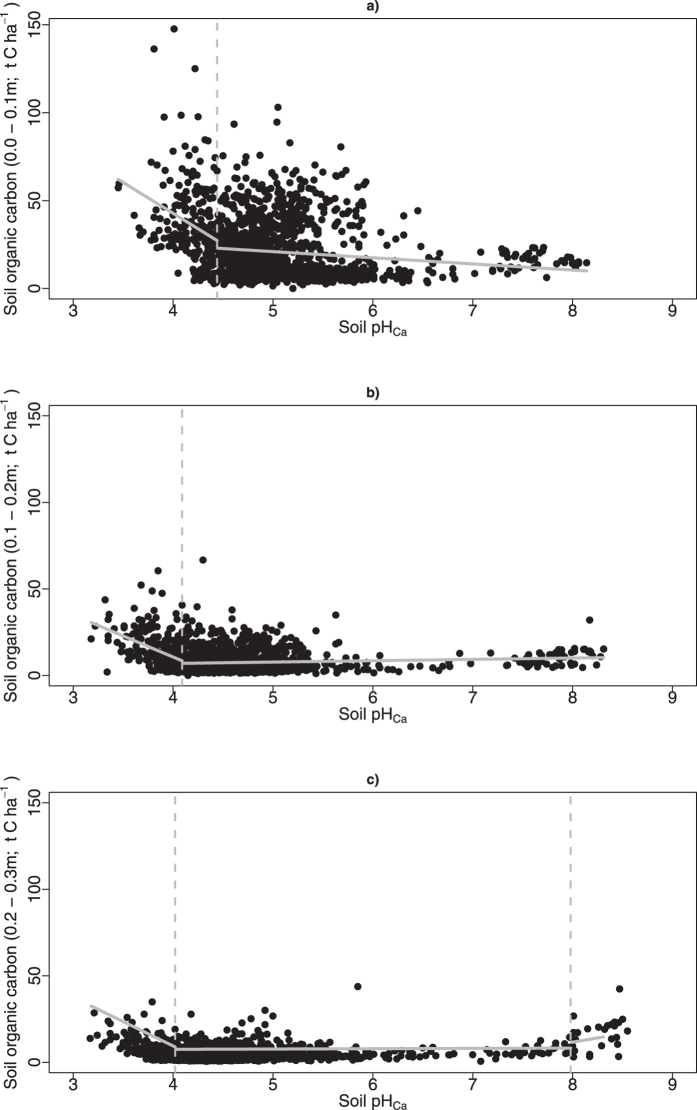
Total soil organic carbon (t C ha−1) in soils from (a) 0–0.1 m, (b) 0.1–0.2 m and (c) 0.2–0.3 m for 1348 sample points in Western Australia against soil pH.The black circles are the observed data, grey vertical dash lines are the change points and grey solid lines are the regressions applied to below and above the change point.